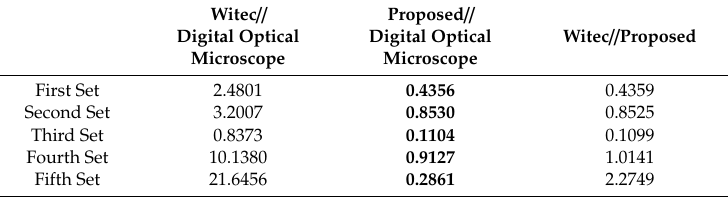
Table 4. For the evaluation of image sharpness, it is worth noting that the Third Set, the Fourth Set, the Fifth Set is mentioned at the end of the article.